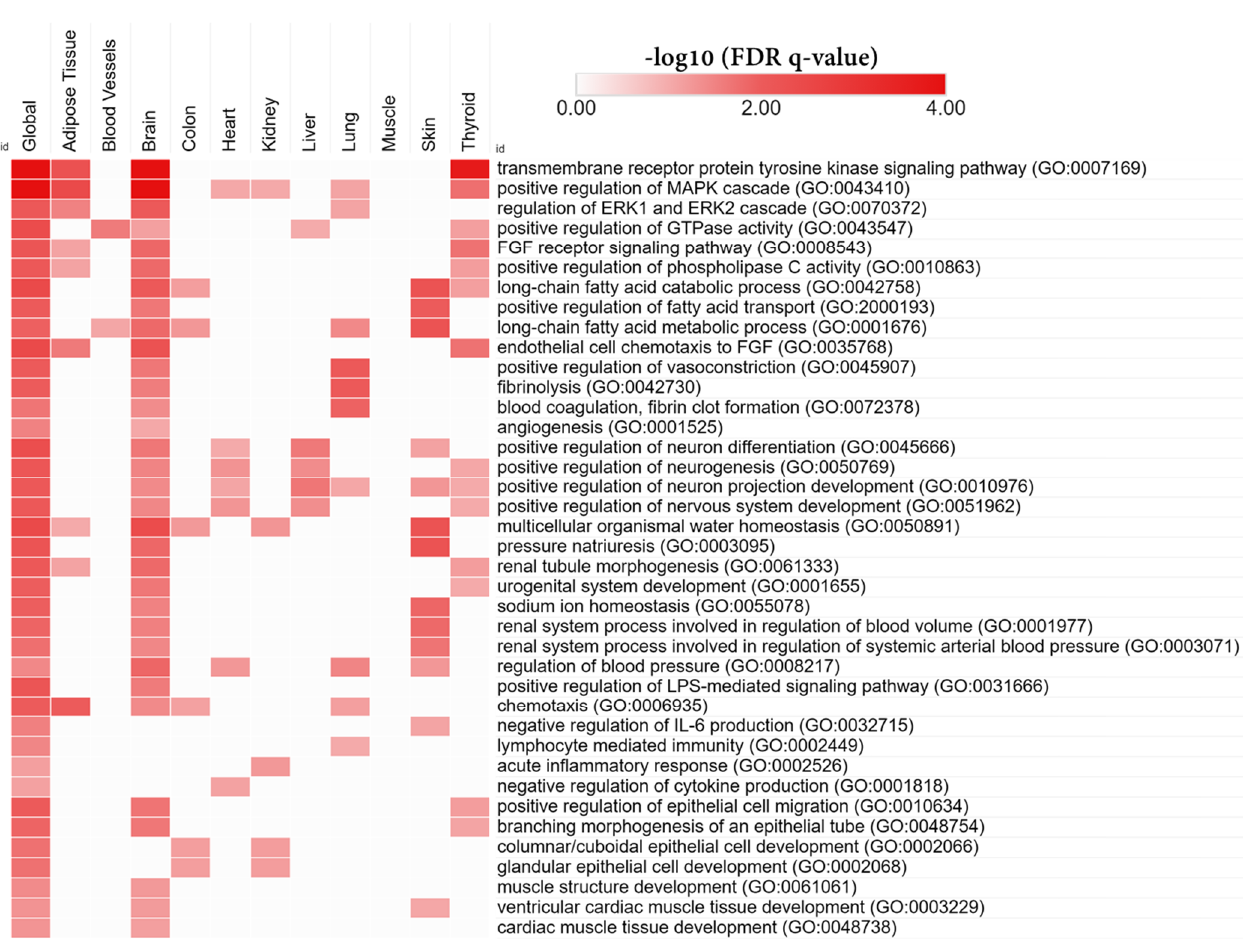
Figure 4. Tissue-specific network-based functional analysis of the upregulated DEGs.